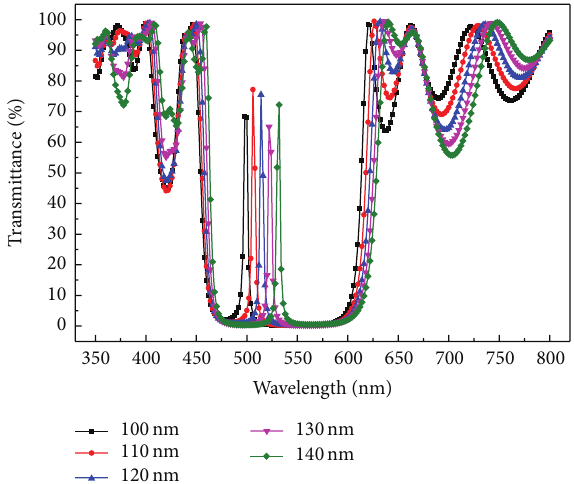
Figure 5: Transmitted spectrum of one-dimensional photonic crystal with different thickness of defect layer.